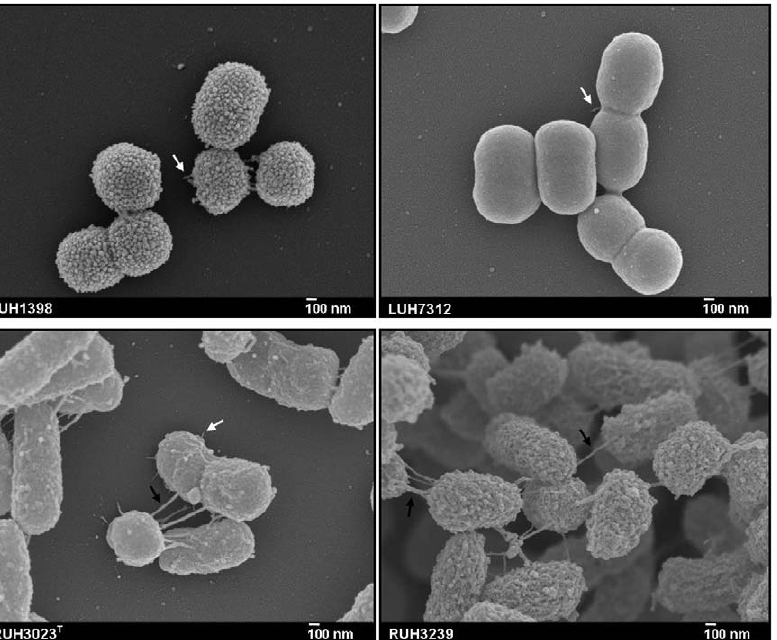
Figure 4. Scanning electron micrographs of A.baumannii . Scanning electron micrographs of A. baumannii strain LUH1398, LUH7312, RUH3023, and RUH3239. Black arrows indicate long cell extensions; white arrows indicate short pili-like structures. Magnification: 30,000 6 . Bars: 100 nm.